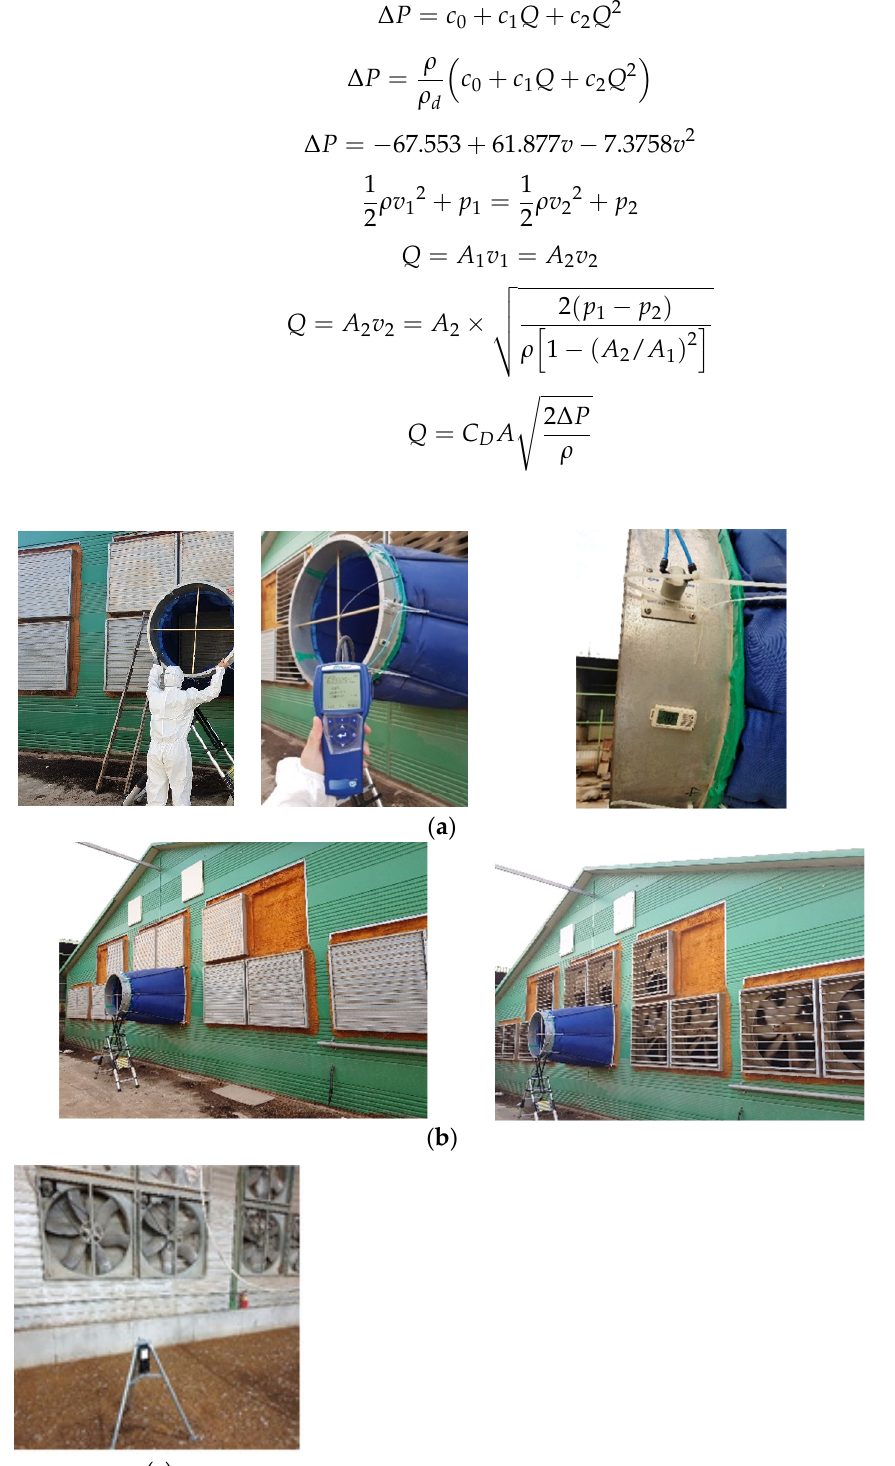
Figure 6. Measurement the ventilation flow rate of the broiler house of exhaust fan: ( a ) Installation of an air flow meter in the tunnel exhaust fan; ( b ) Ventilation flow rate change according to the number of fans; ( c ) Internal static pressure of exhaust fan.